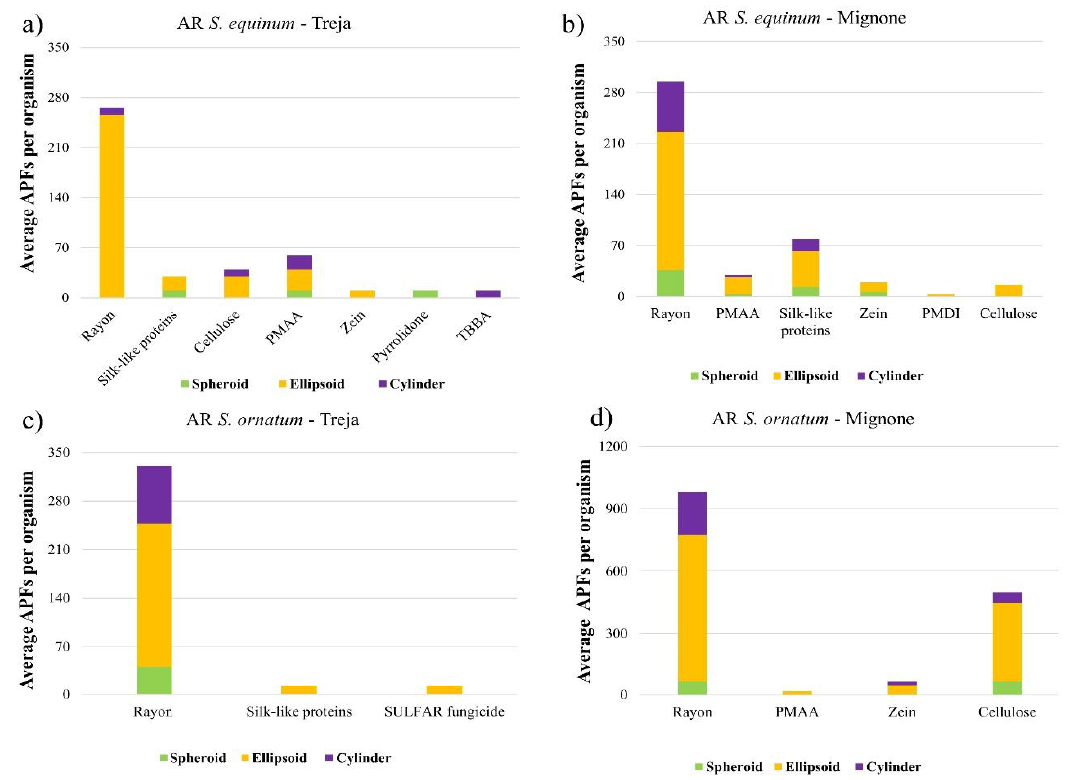
Figure 7. Aspect ratio (AR) of the APFs identified and quantified in specimens of S. equinum ( a , c ) and S. ornatum ( b , d ) under examination. The number of the spheroid, ellipsoid, and cylinder particle shapes is reported for the average abundance of each particle identified and quantified via microscopic counting.